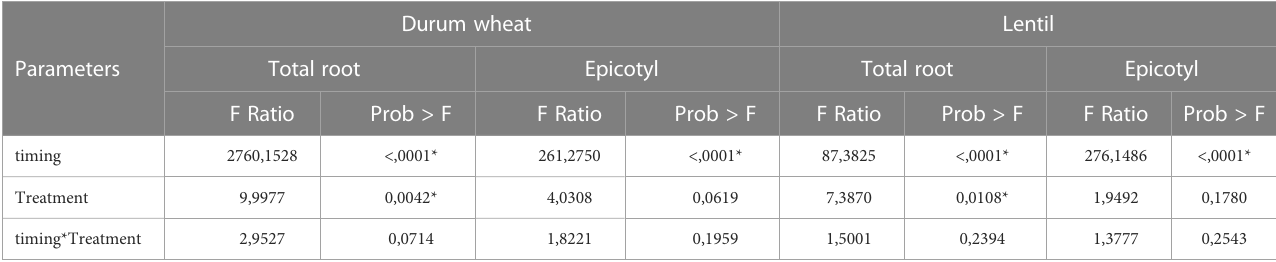
TABLE 3 Statistical analysis of all growth parameters according to a two-way ANOVA for timing (t), Treatment (T), and their interaction (t x T) in both species.